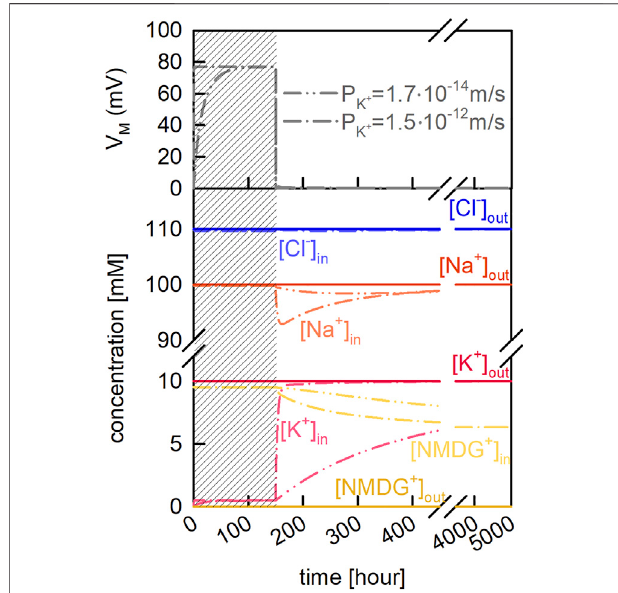
FIGURE 2 | Passive ion permeation through the vesicular membrane. Vesicle assay kinetics simulated with two different P M values for potassium (taken from Table 2 of Paula et al. [Paula et al., 1996)]. Dash-dot-dotted lines and dash-dotted lines show simulations in which P K + was set to 1 . 7 · 10 − 14 m / s , and 1 . 5 · 10 − 12 m / s , respectively. The initial extraluminal concentrations were 100 mM NaCl, 20 mM HEPES, and 10 mM KCl. The initial intraluminal concentrations were 100 mM NaCl, 20 mM HEPES, and 10 mM NMDG + Cl − . The pH on both sides of the membrane was 7.5. Upper panel. Time course of the change in membrane potential ( V M ) . On start of the simulations,K + wastheonlypermeablesolute(greyshadedarea).After150 h, all other ions ( H + , Na + , NMDG + , and Cl − ) were allowed to permeate. Lower panel. Evolution of all intra- (bright colors) and extraluminal (dark color) ion concentrations (except for H + ) over